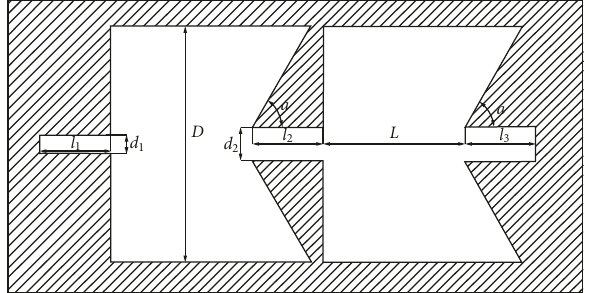
Figure 4: Diagram of the internal structure of the Helm- holtz+Helmholtz cavitation nozzle.